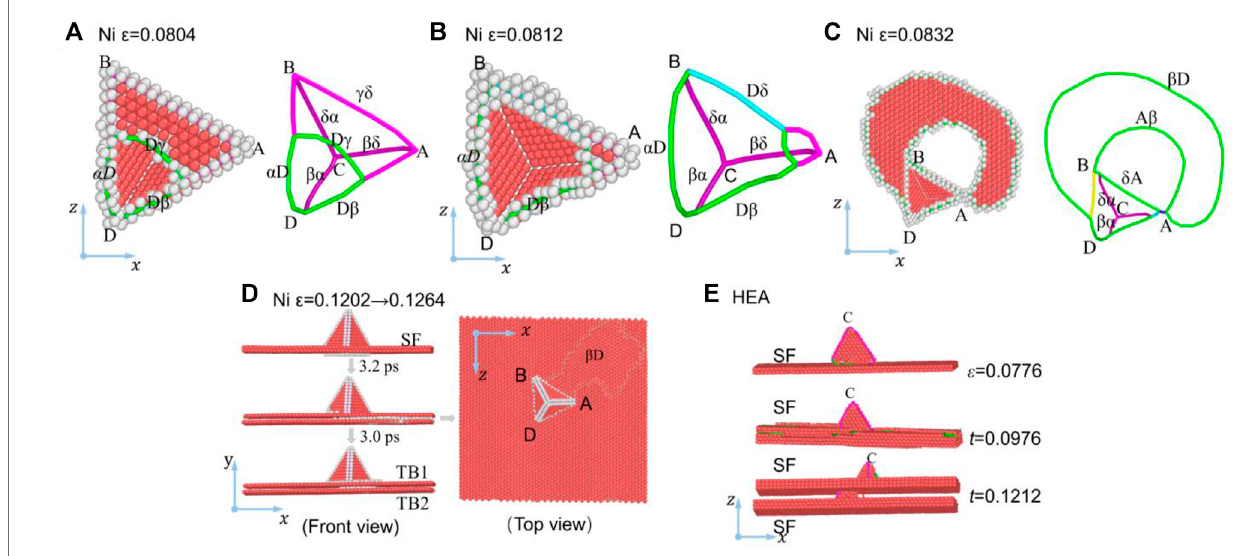
FIGURE 5 | Atomic structures of SFTs in Ni and CoCrFeNiMn samples sheared along ( 111 )[ 110 ] at different shear strains. (A – D) Ni. (E) CoCrFeNiMn HEA.